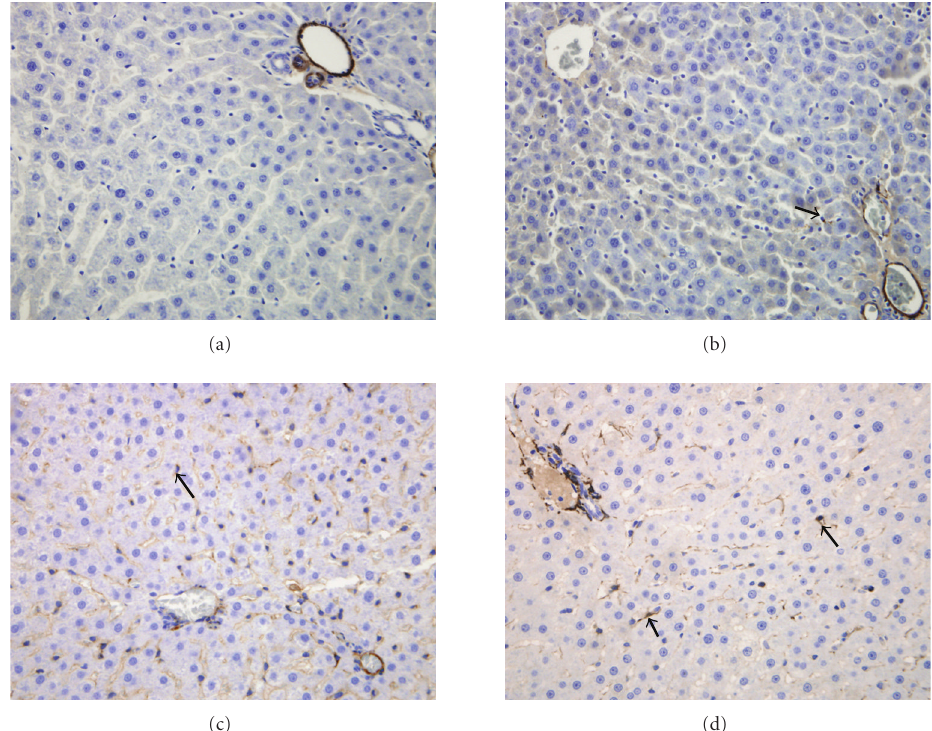
Figure 4: Representative immunohistochemistry from rat livers showing SMA in young (a) and old (b) rats, and desmin immunostaining in young (c) and old (d) rats (magnification × 200).